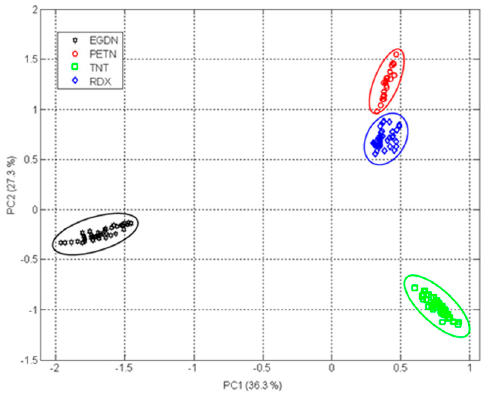
Figure 5. PCA 2D score plot of PC1 vs. PC2 for the SERS spectra dataset.